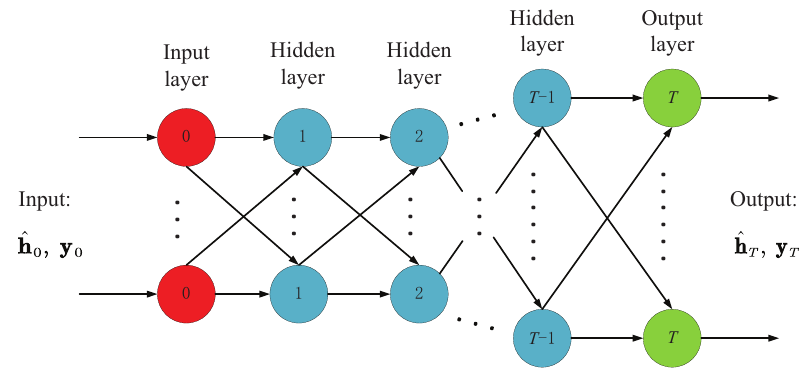
Figure 1. LAMP network structure with a total of T